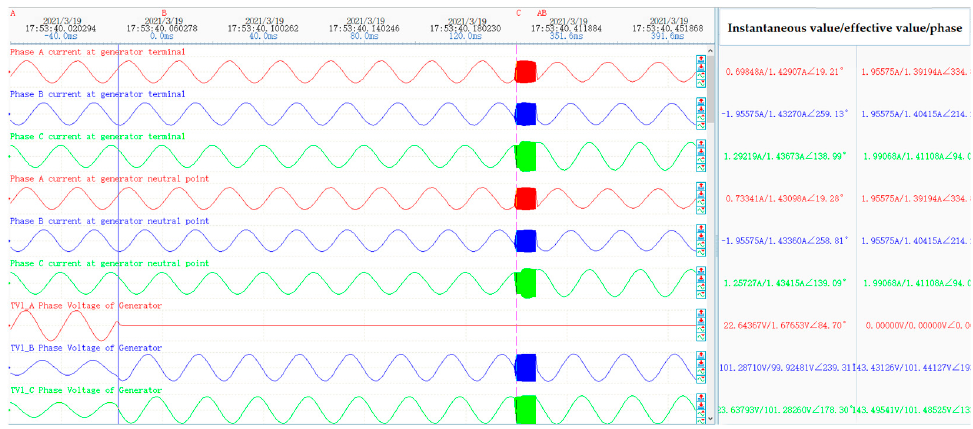
Figure 12. Waveform diagram of dynamic experiment results. Table 4. Results of calculation data of dynamic model experiments.